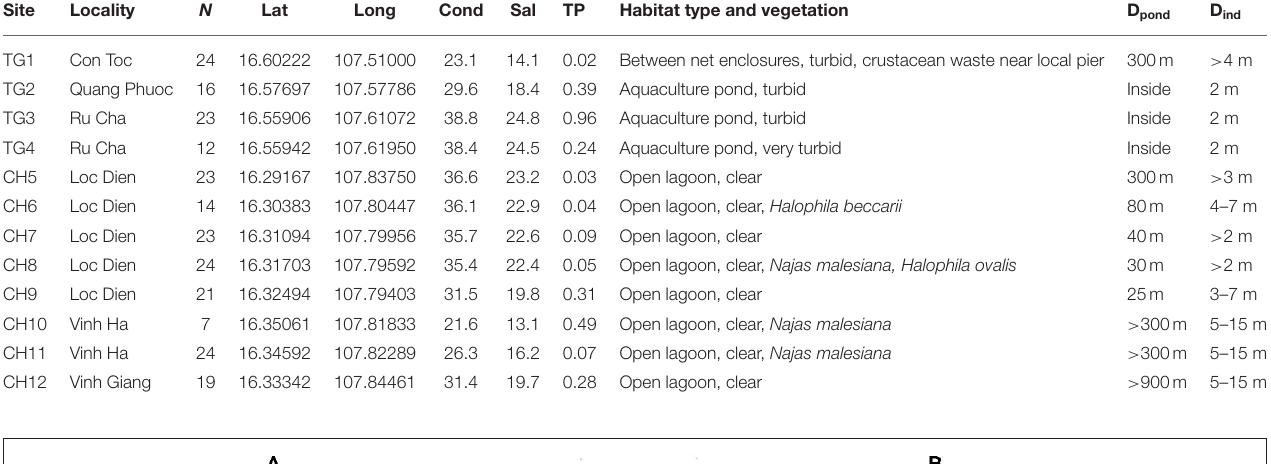
TABLE 1 | Characteristics of 12 sites in the Tam Giang (TG)-Cau Hai (CH) lagoon system (Viet Nam) with N: number of samples; decimal coordinates; conductivity (mS/cm); salinity ( ‰ ); total phosphorus (TP in mg/l); habitat features; D pond : distance to nearest aquaculture pond (m) and D ind : distance interval between individual samples (m).